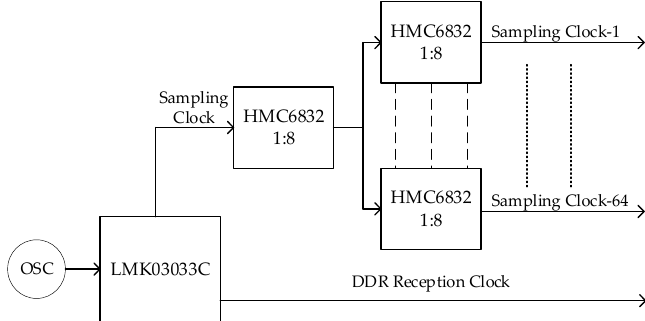
Figure 7. Schematic of the clock tree.